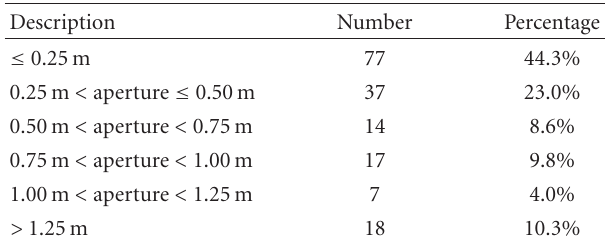
Table 2: Range of RAO’s main instrument apertures (adapted from